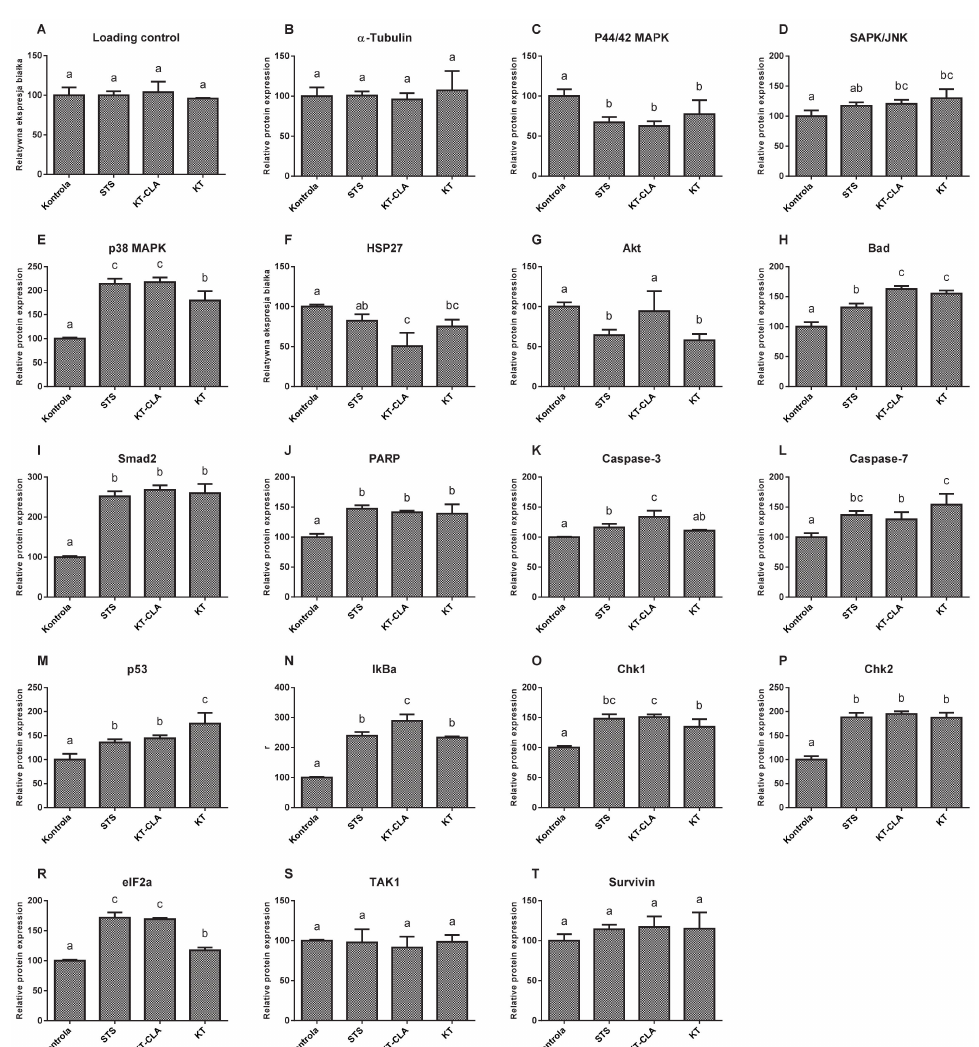
Figure 8. Effect of a mixture of fatty acids extracted from CLA-enriched and non-enriched yolk on the expression of individual apoptosis- and stress-related proteins in cancer cells of the WM793 line. The Tukey test was used for statistical analysis. Values marked with different letters are significantly different at p ≤ 0.05. ( A ) loading control, ( B ) reference protein, ( C – T ) analyzed proteins. The results are presented as mean, ± SD for n = 4 in relation to untreated cells (control), a–c—means with the same letter are not significantly